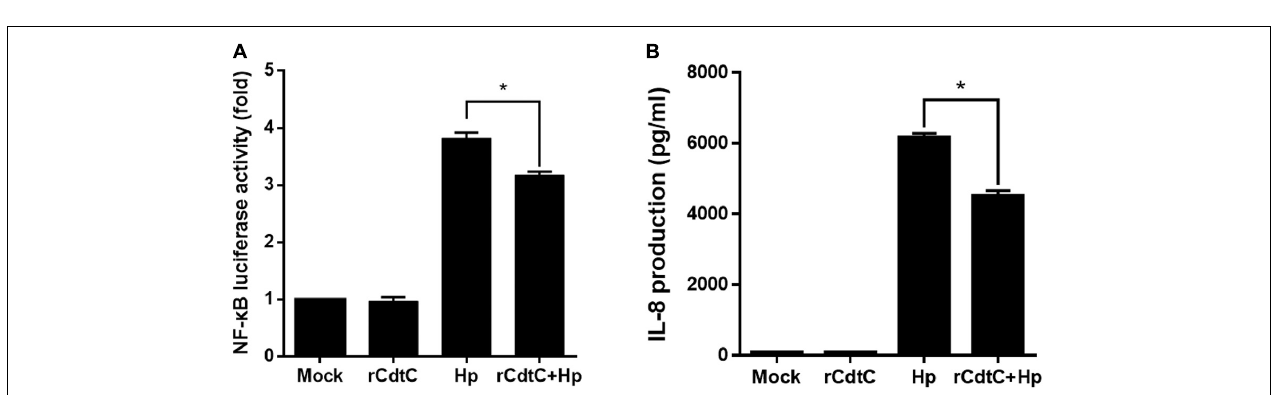
FIGURE 5 | rCdtC suppresses NF- κ B activation and IL-8 production in Helicobacter pylori -infected cells. AGS cells were untreated with rCdtC (mock), treated with 200 nM rCdtC, infected with H. pylori at a multiplicity of infection of 100 for 6 h, or pretreated with rCdtC then infected with H. pylori . (A) The level of NF- κ B activation was determined by luciferase assay. (B) IL-8 production was assessed using ELISA. Each group was performed in triplicate experiments (* P <